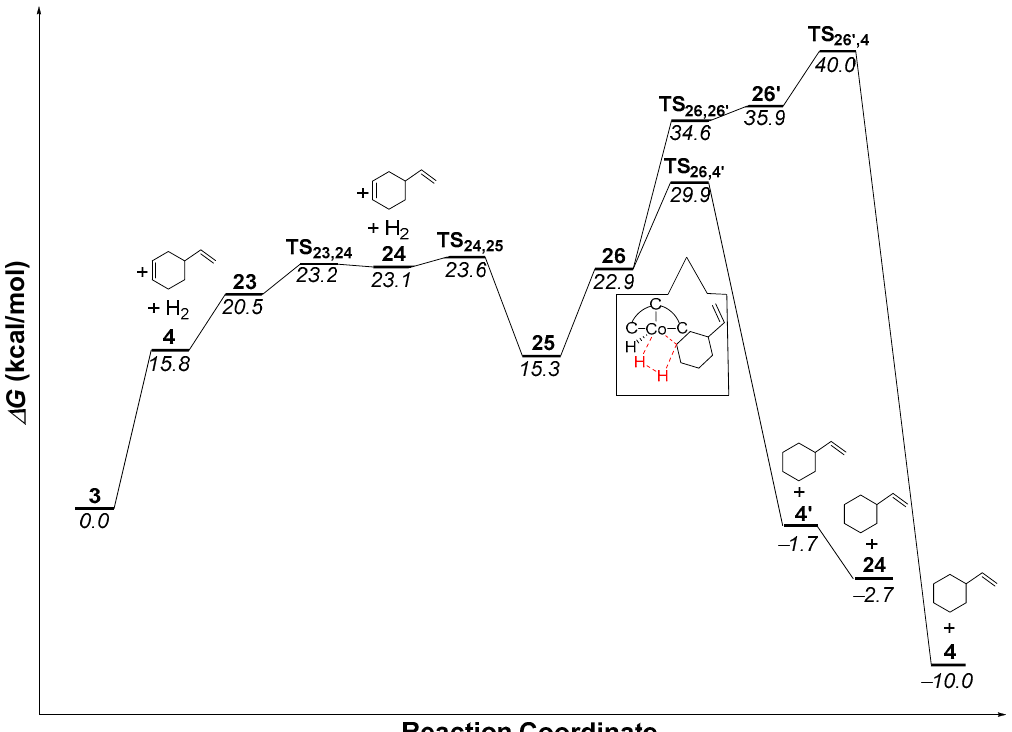
Figure 11. Free energy profile for the hydrogenation of 4-vinylcyclohex-1-ene to vinylcyclohexane catalyzed by ( Mes CCC)Co complexes.